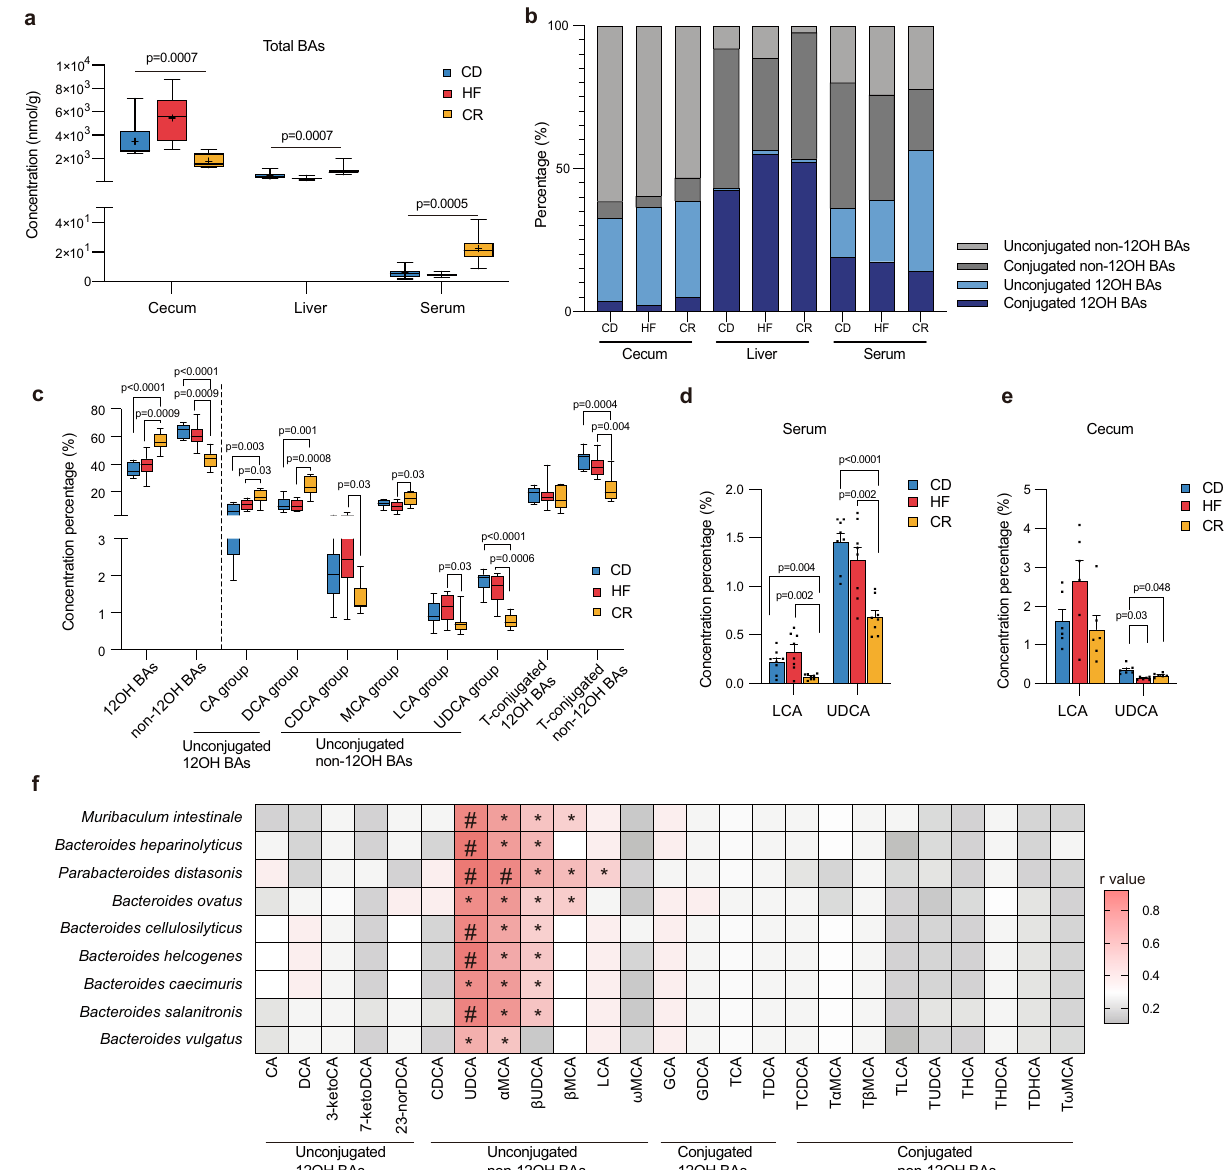
Fig. 3 The depletion of Parabacteroides distasonis and non-12OH BAs in CR. a Concentration of total BAs in contents of cecum, liver, and serum among three groups. Three groups variation was assessed by the Kruskal – Wallis test. b The bar plots show the mean percentage of (non-)12OH and (un) conjugated BAs in contents of cecum, liver, and serum among three groups. c The BAs concentration percentage pro fi les in the serum of three groups. d Dysregulated non-12OH unconjugated BAs (LCA and UDCA) composition in the serum of three groups. e Dysregulated non-12OH unconjugated BAs (LCA and UDCA) composition in the cecal contents of three groups. f Heatmap of GRaMM ’ s correlation coef fi cients between the cecal BAs and the species signi fi cantly enriched in the CD group, the color of each spot in the heatmap corresponds to the r value, * p < 0.05; # p < 0.0001. n = 8 per group. Differences in the BAs concentration percentage data were assessed by the two-tailed multiple T-test in the GraphPad software, p -values were adjusted by the FDR ’ s method. Data are expressed as mean ± SEM in ( d , e ). All box and whiskers plots showed the box (from the 25th to 75th percentiles), the median value (in the transverse line), and the whiskers (go down to the smallest value and up to the largest). Source data are provided as a Source data fi le. 12 α - hydroxylated bile acids (12OH BAs); non-12 α -hydroxylated bile acids (non-12OH BAs); T-conjugated (taurine-conjugated); cholic acid (CA); deoxycholic acid (DCA); chenodeoxycholic acid (CDCA); muricholic acid (MCA); lithocholic acid (LCA); ursodeoxycholic acid (UDCA); 3-ketocholic acid (3-ketoCA); 7-ketodexycholic acid (7-ketoDCA); 23-nordeoxycholic acid (23-norDCA); α -muricholic acid ( α MCA); 3 β -ursodeoxycholic acid ( β UDCA); β -muricholic acid ( β MCA); ω -muricholic acid ( ω MCA); glycocholic acid (GCA); glycodehydrocholic acid (GDCA); taurocholic acid (TCA); taurodeoxycholic acid (TDCA); taurochenodeoxycholic acid (TCDCA); tauro α -muricholic acid (T α MCA); tauro β -muricholic acid (T β MCA); taurolithocholic acid (TLCA); tauroursodeoxycholic acid (TUDCA); taurohyocholic acid (THCA); taurohyodeoxycholic acid (THDCA); taurodehydrocholic acid (TDHCA); tauro ω - muricholic acid (T ω